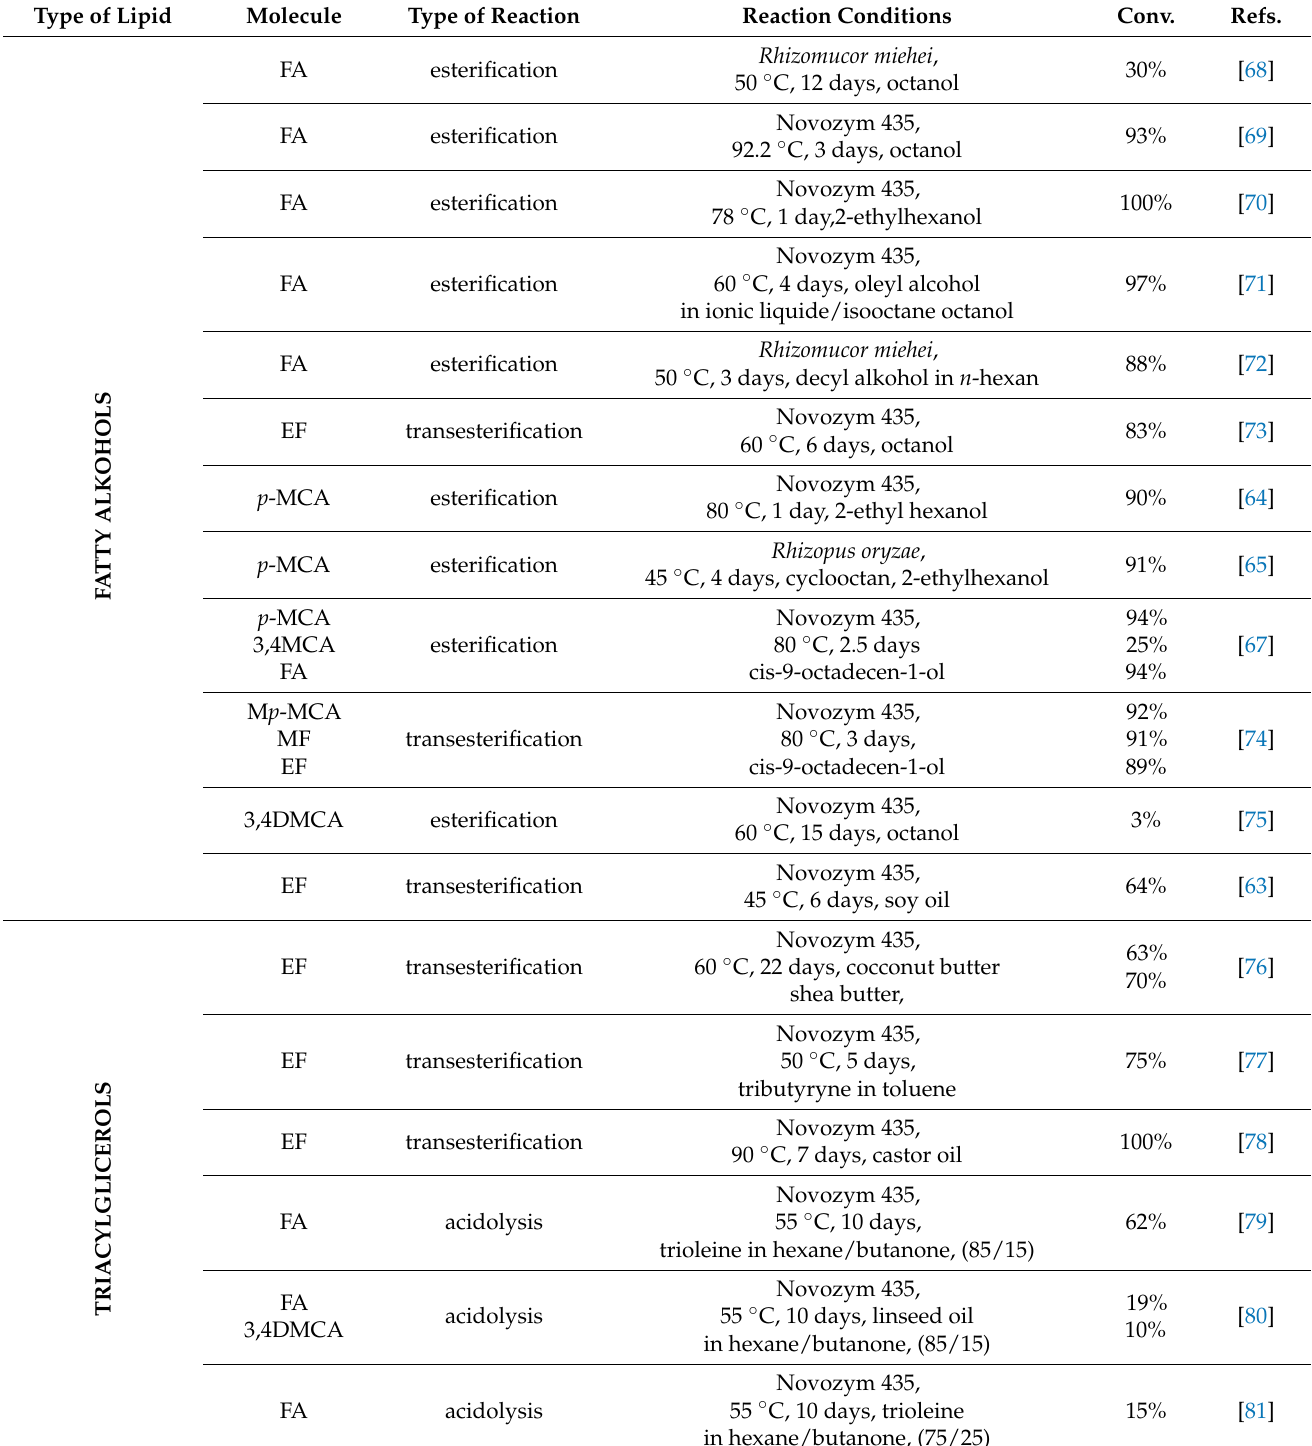
Table 2. Lipase-catalyzed modification of methoxylated derivatives of cinnamic acid with neutral fatty acids and triacyl-